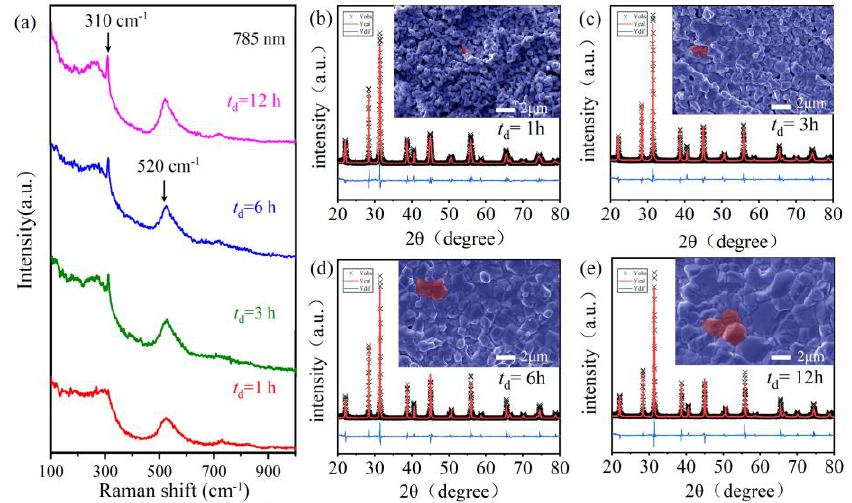
Figure 3. ( a ) Room-temperature Raman spectra in the low-wavenumber region of 100 − 1000 cm − 1 for for BGTH7 powder sintered for different t d at T s = 1400 ◦ C. The results of the XRD refinement and BGTH7 powder sintered for different t d at T s = 1400 °C. The results of the XRD refinement and SEM images for BGTH7 ceramics sintered with different t d at T s = 1400 °C. ( b ) t d = 1 h, ( c ) t d = 3 h, ( d ) t d = SEM images for BGTH7 ceramics sintered with different t d at T s = 1400 ◦ C. ( b ) t d = 1 h, ( c ) t d = 3 h, 6 h, ( e ) t d = 12 h. ( d ) t d = 6 h, ( e ) t d = 12